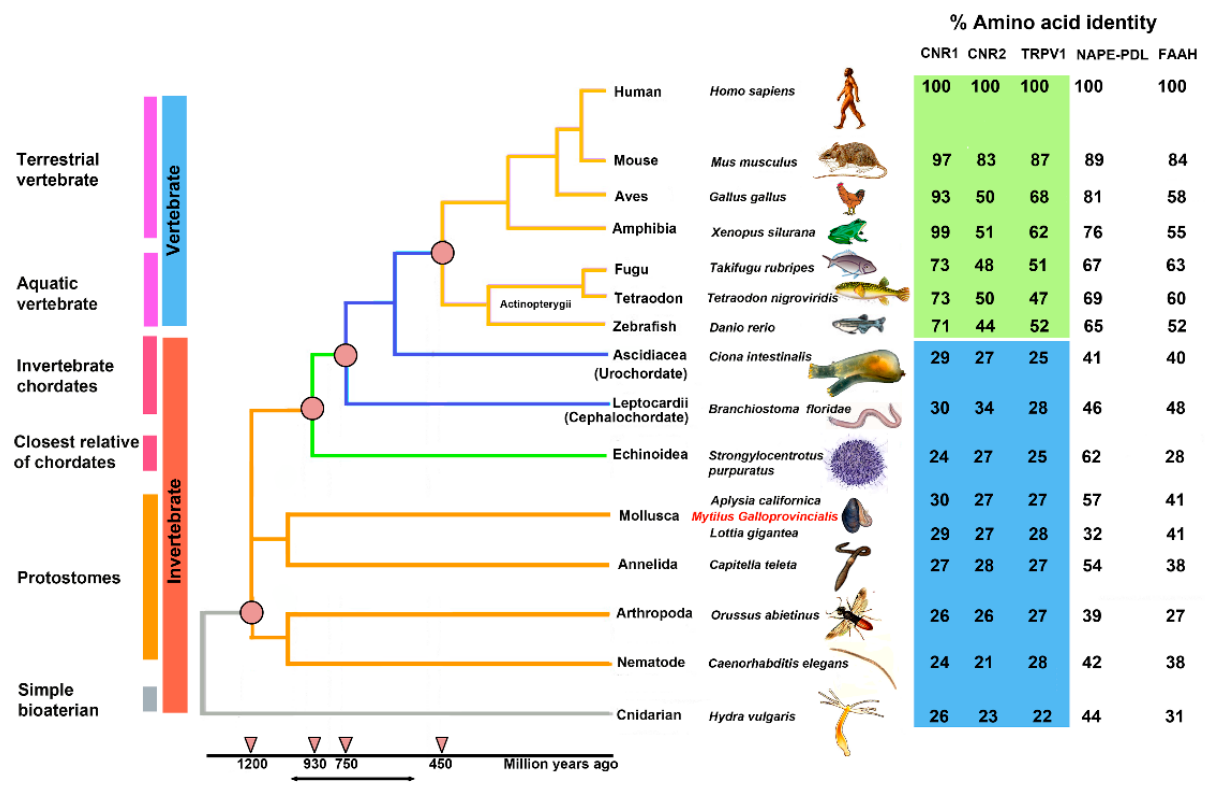
Figure 2. A phylogenetic “Tree of Life” of ECS in 15 species of vertebrates (blue) and invertebrates (orange), divided into six physiological groups: terrestrial vertebrate, aquatic vertebrate, invertebrate chordates, closest relative of chordates, protostomes, and simple bilaterian.